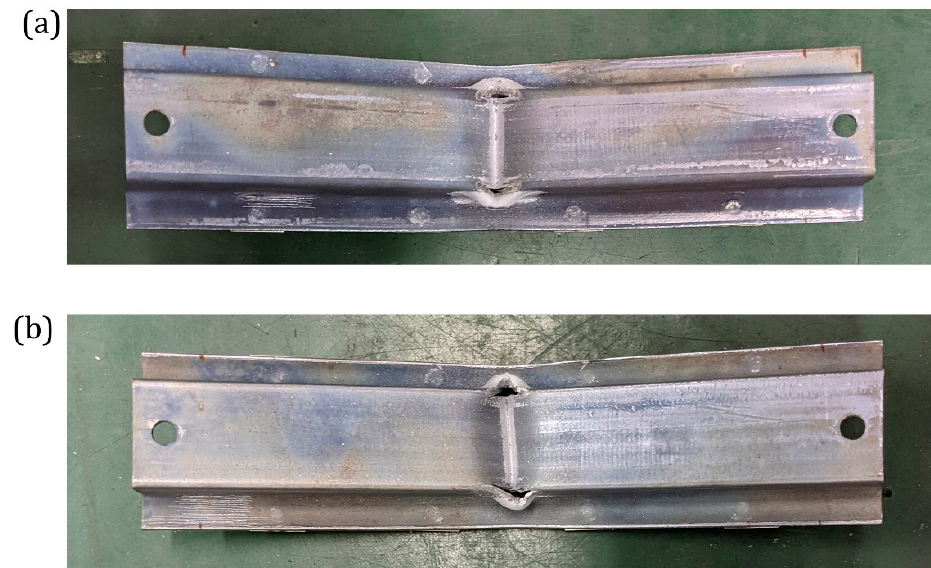
Figure 18. Hot-hat bent parts after bending test for ( a ) d L = 0 mm and ( b ) 10 mm.